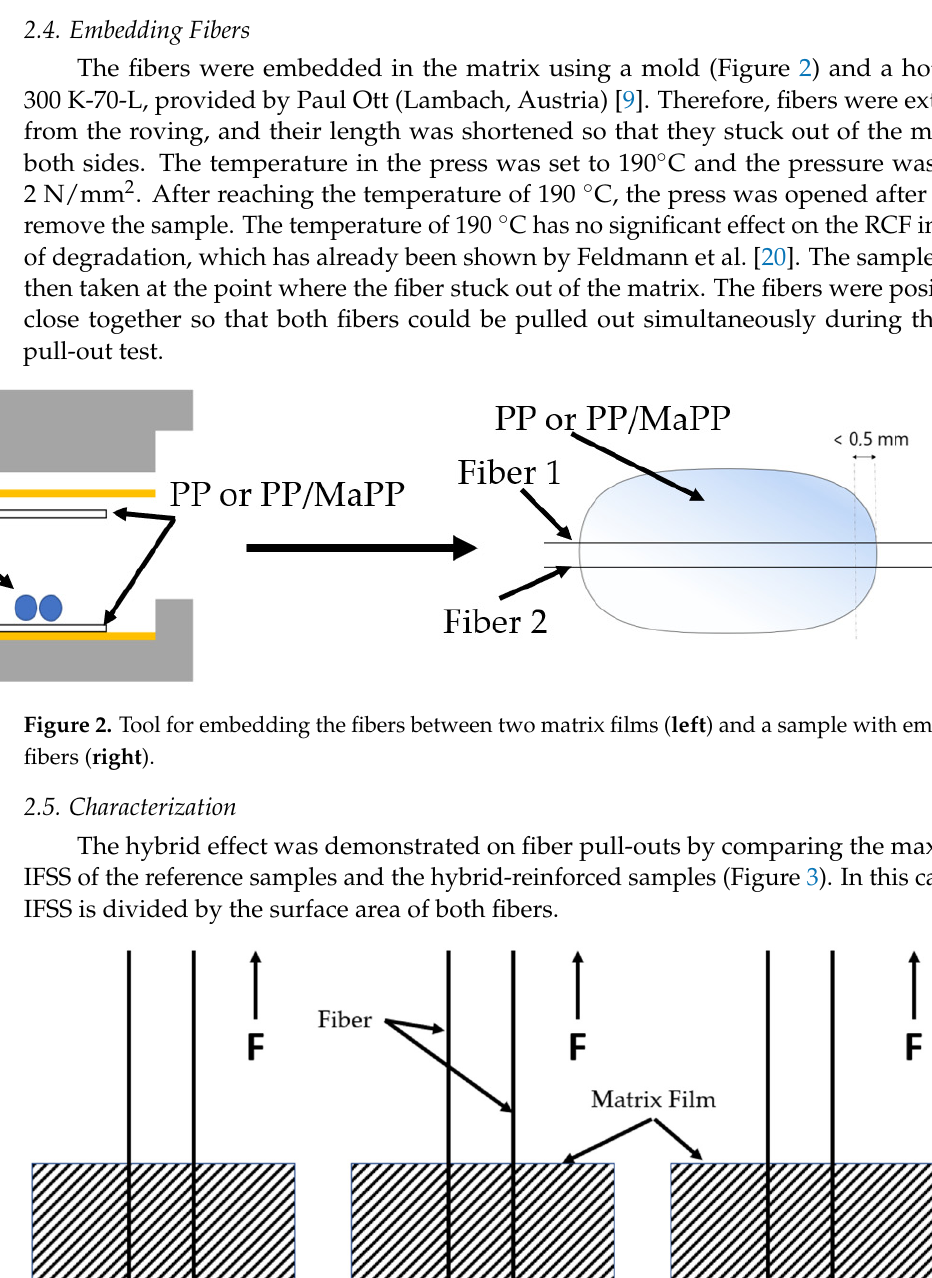
Figure 1. Schematic treatment of RCF with UV light.